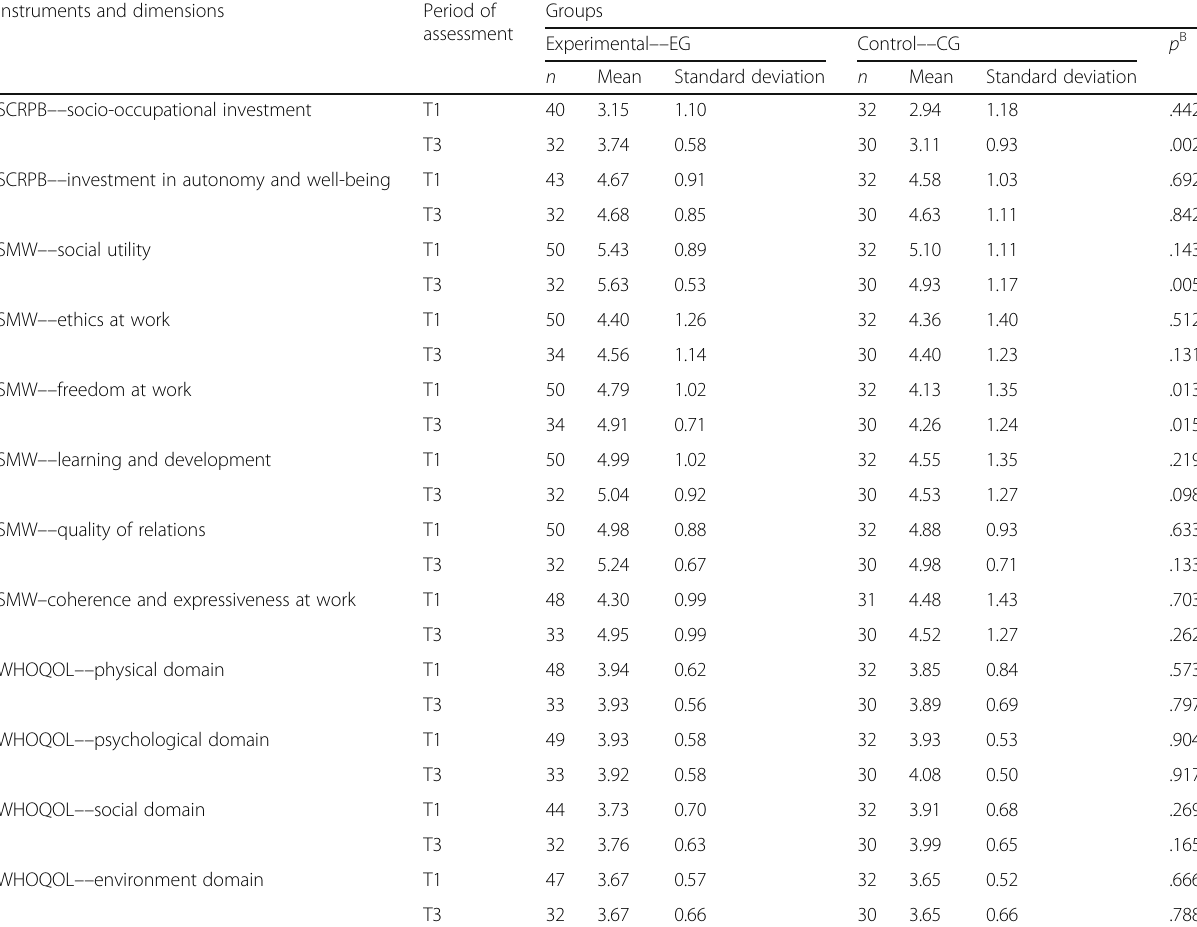
Table 3 Mean and standard deviation for scores of the instruments SCRPB, SMW, and WHOQOL-Brief, according to the assessments T1 and T3 on the total of valid cases Instruments and